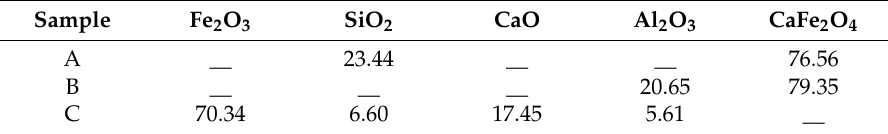
Table 1. Composition of the starting sample (mass